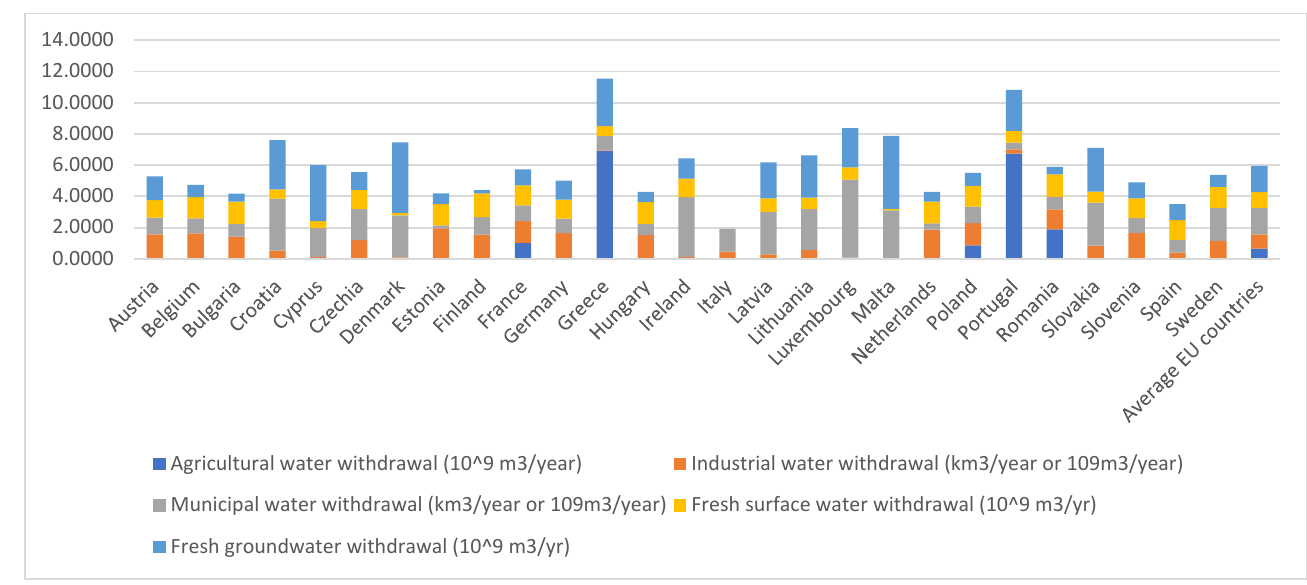
Figure 7. Water consumption indicators of EU countries.